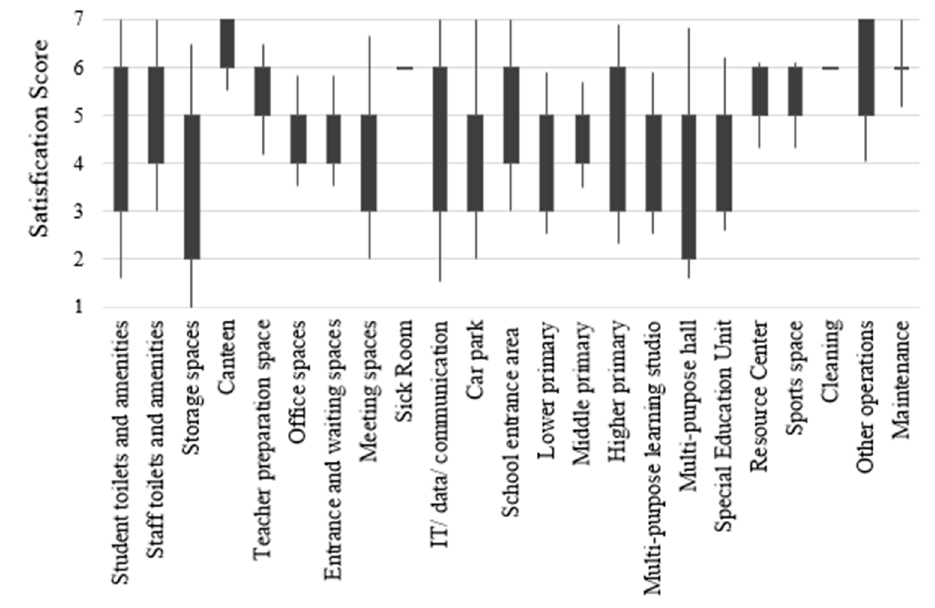
Figure 6. Satisfaction analysis for PPP schools.